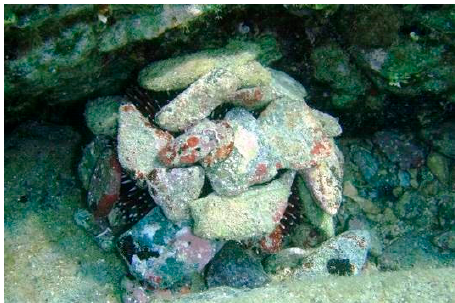
Figure 1. Covering behavior of the sea urchin Sphaerechinus granularis : underwater photography of a specimen in station 2, S2 (photo from Dr. Alexios Lolas).